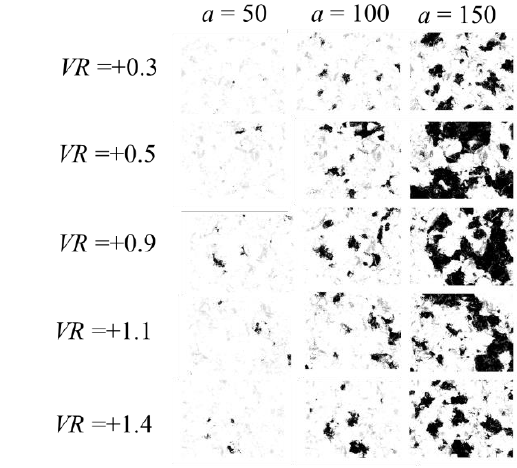
Figure 3. Comparison of binary images.